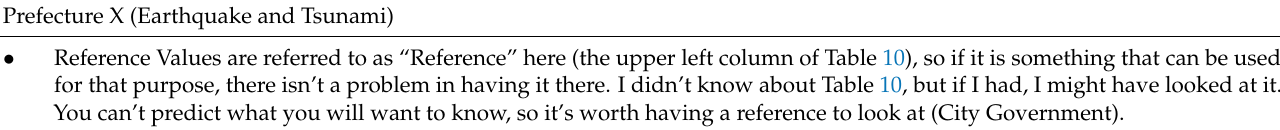
Table 11. Are Reference Values for each age group needed?